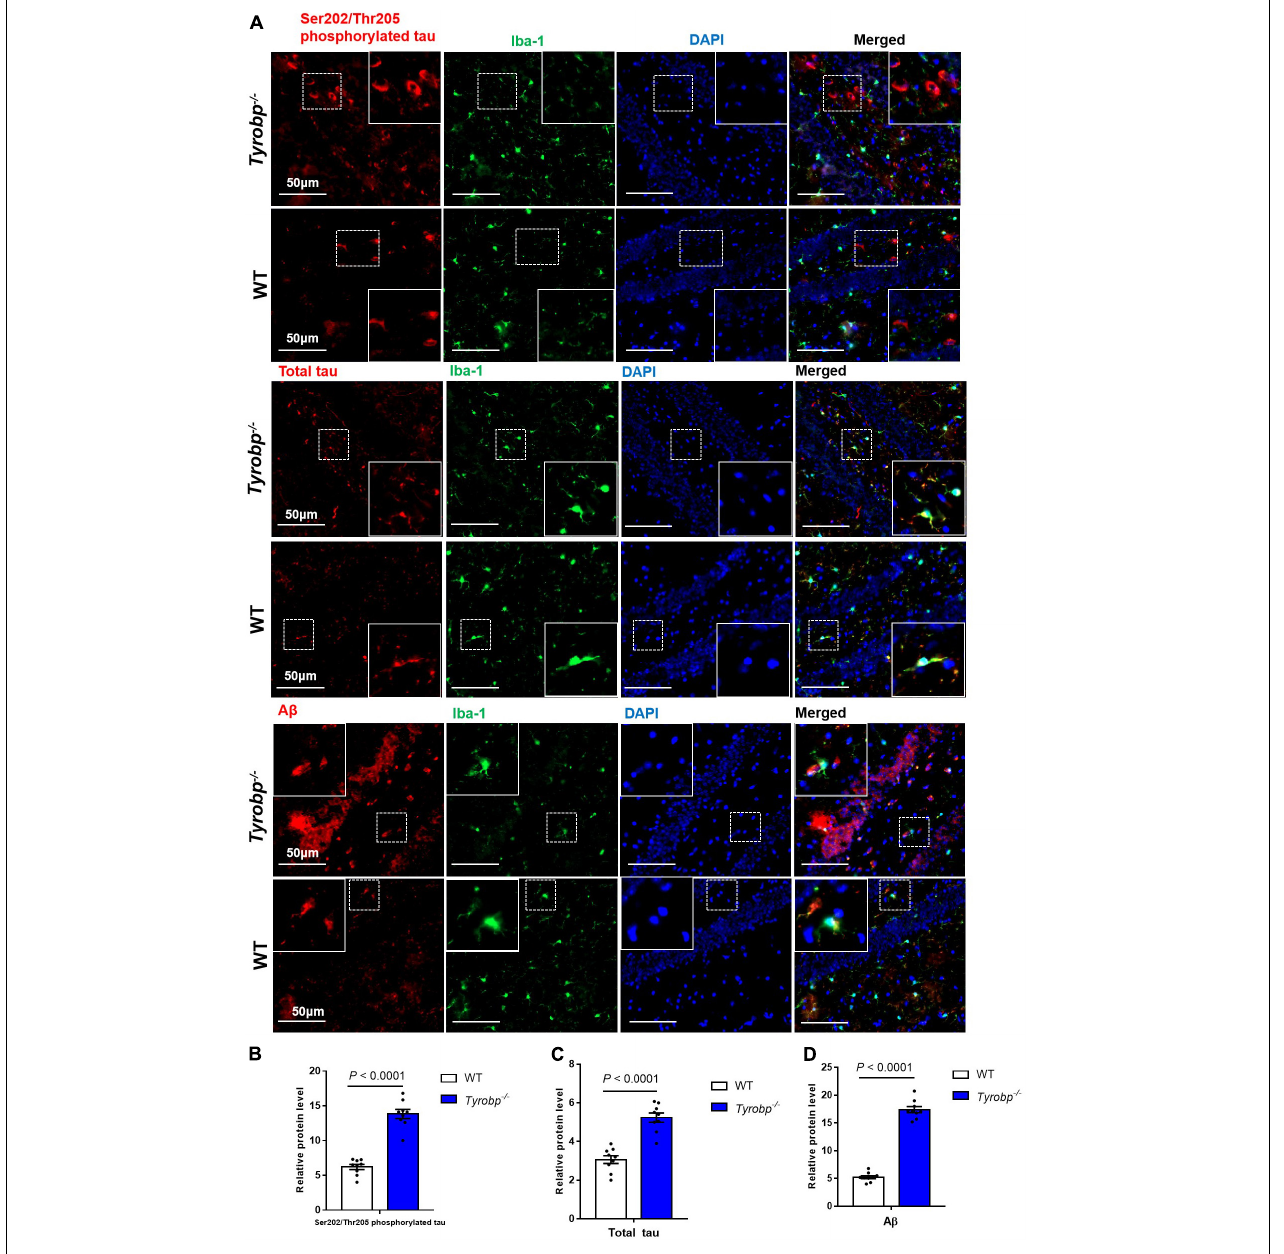
FIGURE 3 | Numbers of hippocampal cells immunopositive for total tau, Ser202/Thr205-phosphorylated tau, and A β . Tissues from hippocampus of wild-type (WT) and Tyrobp − / − mice aged 6 months were immunostained for total tau (tau-5), Ser202/Thr205-phosphorylated tau (AT8), and A β (6E10). (A) Representative micrographs. (B–D) Quantification of total tau, Ser202/Thr205-phosphorylated tau, and A β . Data are mean ± SEM from three independent experiments (three mice per group). Differences were assessed for significance using Student’s t